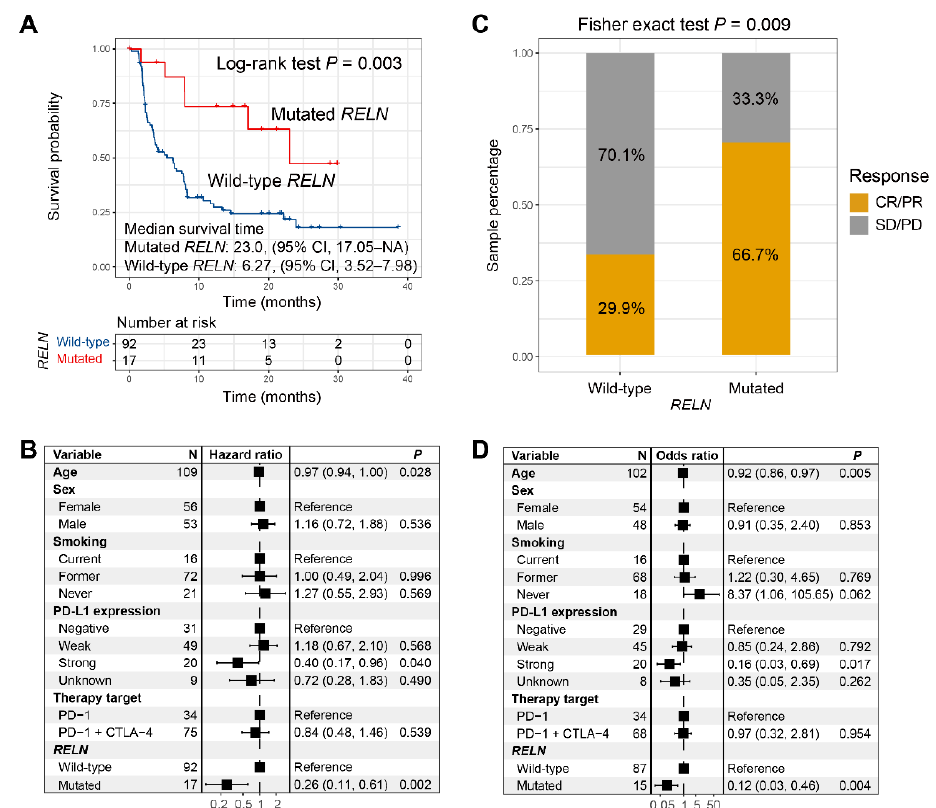
Figure 3. ICI treatment prognosis and response rate analyses of RELN mutations in NSCLC. ( A ) Survival curves of RELN -mutated and wild-type NSCLC patients. ( B ) Multivariable Cox regression analysis of RELN mutations was performed with clinical confounders taken into consideration. ( C ) Bar plot representation of ICI response rates of RELN -mutated and wild-type patients. ( D ) Multi- variable logistic regression analysis of RELN mutations was achieved with multiple confounding variables adjusted.